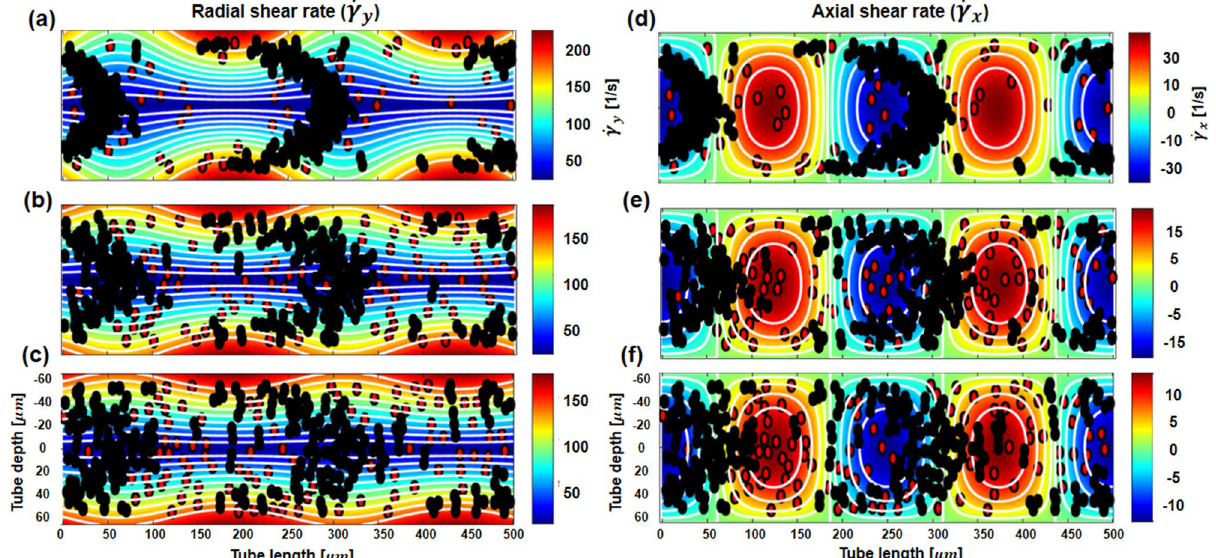
Figure 3. 2D simulation results of RBC motion under sinusoidal pulsatile flow, corresponding to the spatial variation in two different components of shear rate. White lines represent the same shear rate range with equal area divided into 10 intervals. The RBC kinetics between hydrodynamic properties and local RBC aggregation were observed by decreasing the amplitude of velocity from 1.3 to 1.0 and 0.5 mm/s with a mean flow velocity of 4 mm/s (shown from top to bottom). When the velocity amplitude decreased, the maximum ranges of the radial and axial shear rates also decreased. ( a – c ) and ( d – f ) are the distribution of RBC aggregation coincided with the radial and axial shear rate fields, respectively. The spatial variation in axial shear rate is obviously related to the parabolic rouleaux distribution and local hematocrit, following the contour lines from the minimum to increasing axial shear rate. A supplementary video file is provided to show the dynamic RBC motion with shear rate fields for ( a ) and ( d ) (Supplementary video S1).